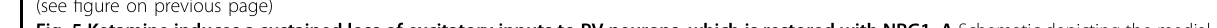
Fig. 5 Ketamine induces a sustained loss of excitatory inputs to PV neurons, which is restored with NRG1. A Schematic depicting the medial prefrontal cortex (mPFC) region of mouse brain from which recordings were taken. B Schematic of laser-scanning photostimulation (LSPS) mapping of cortical synaptic connections to individually recorded PV neurons in mPFC slices. LSPS maps the broad spatial pattern of synaptic inputs to the neuron of interest, and distinguishes direct uncaging responses (1, red) to assess glutamate-mediated excitability/responsiveness at perisomatic locations, and synaptically mediated EPSC responses (2, cyan) to assess synaptic inputs from presynaptic neuronal spiking. Cortical layers of 1, 2/3, 5, and 6 in the brain slice are indicated as L1, L2/3, L5, and L6. Recorded PV neurons are fi lled with biocytin for post-hoc con fi rmation. C Group- averaged, excitatory input maps of PV cells recorded at the speci fi ed conditions. White circles in each map represent individual PV neurons. The color scales code integrated excitatory input strength (blue = low, red = high) and applies to all other maps in the same condition. C (left column) An acute bath application of NRG1 (5 nM) does not signi fi cantly modulate local excitatory synaptic inputs onto PV neurons in mPFC of saline-treatment control mice. Averaged excitatory input maps of L2/3 PV cells are shown before (top), during bath NRG1 (20 min after NRG1 application) (middle), and after washout of bath NRG1 (bottom). C (right columns) Reduced excitatory inputs to PV neurons are seen at 1, 24, 48, and 72 h after ketamine treatment (10 mg/kg; s.c.), but not after 1 week. Excitatory inputs to PV neurons in ketamine-treated mice are restored by acute bath application of NRG1. This acute restoration by NRG1 is eliminated by washout of the bath NRG1. D Summary data of average total synaptic input strength measured for L2/3 PV neurons under the speci fi ed conditions (control, 1, 24, 48, and 72 h and 1 week after ketamine treatment) (Linear mixed effects model (two factors): highly signi fi cant. Two-sample t test (adjusted for multiple comparisons): base vs base (control), 1 h p = 0.0057, 24 h p = 2.76 × 10 − 4